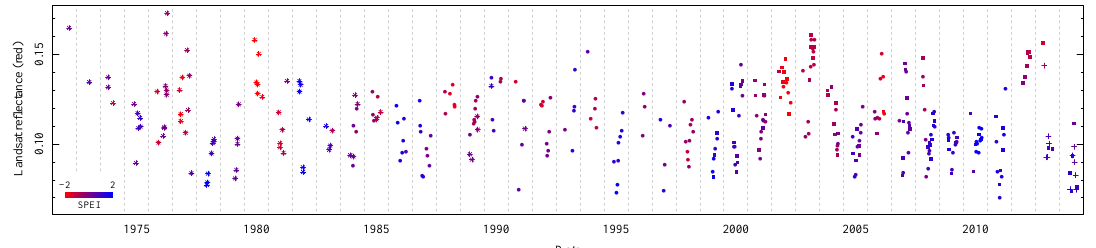
Figure 3. Landsat red reflectance through time for one grassland pixel (45°5 (cid:48) 33.7 (cid:48)(cid:48) N, 102°17 (cid:48) 44.1 (cid:48)(cid:48) W). Colors denote the Standardized Precipitation and Evaporation Index (SPEI) value at the observation time (red = dry, blue = wet). Landsat instrument shown by symbols: MSS (asterisk), TM (circle), ETM (square), and OLI